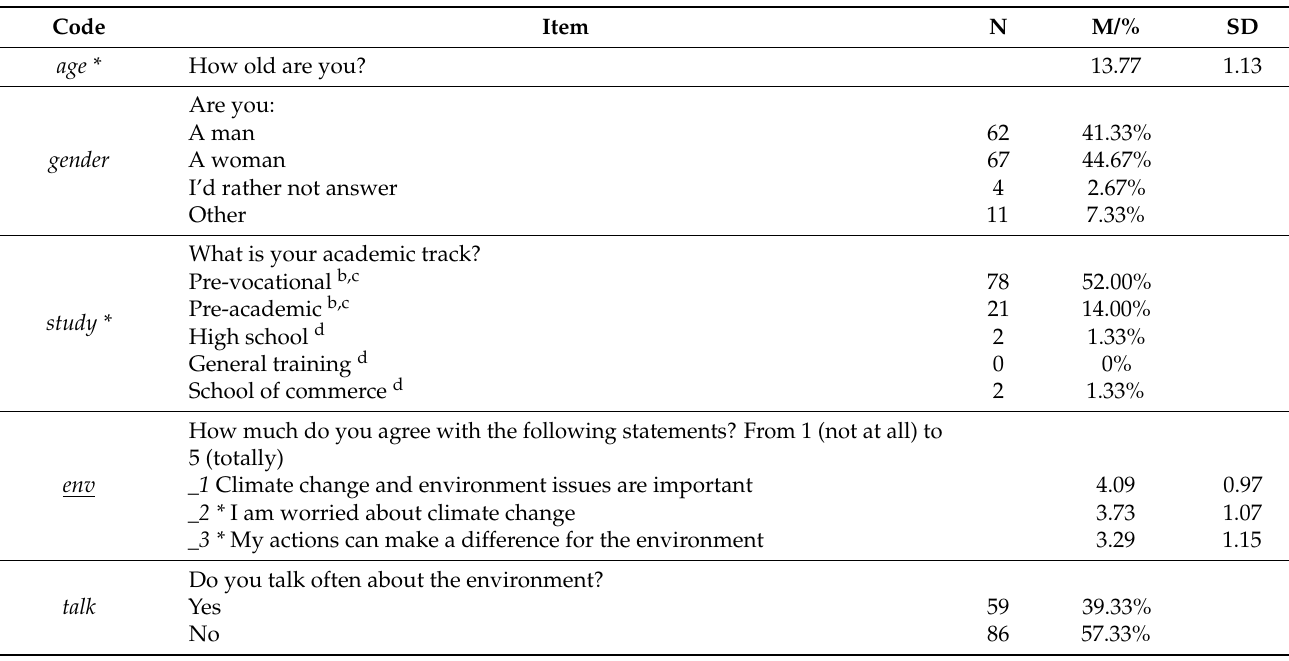
Table A1. Items’ wording (translated into English), frequencies or means, and standard